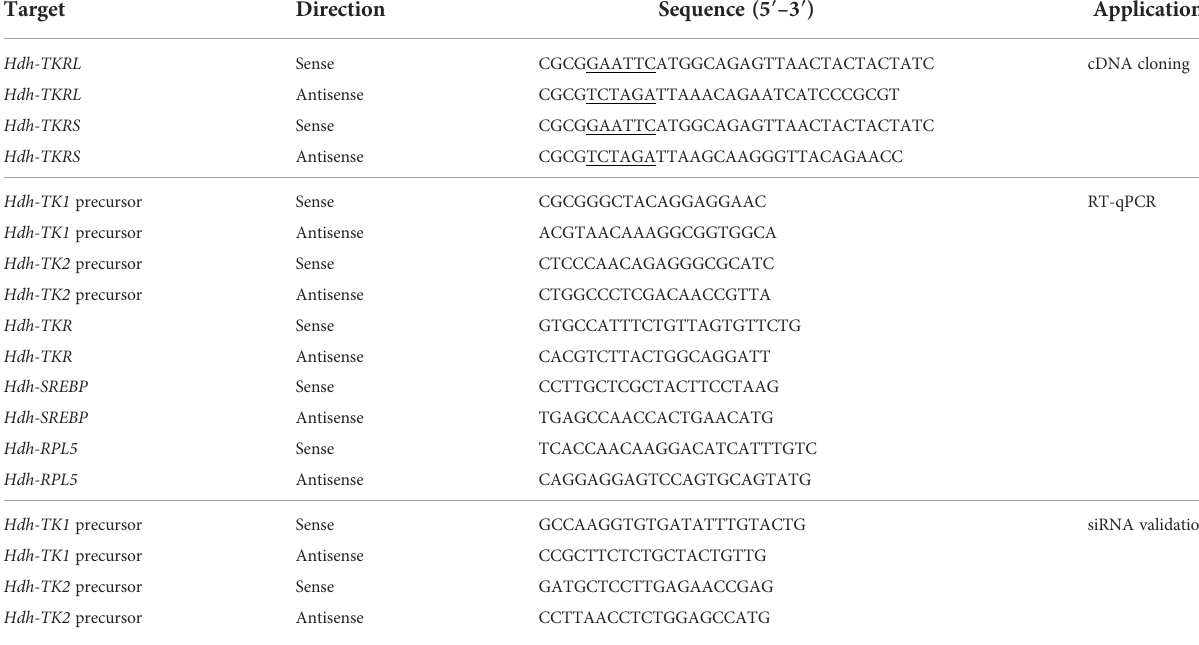
TABLE 1 Oligo primer sequences used in the polymerase chain